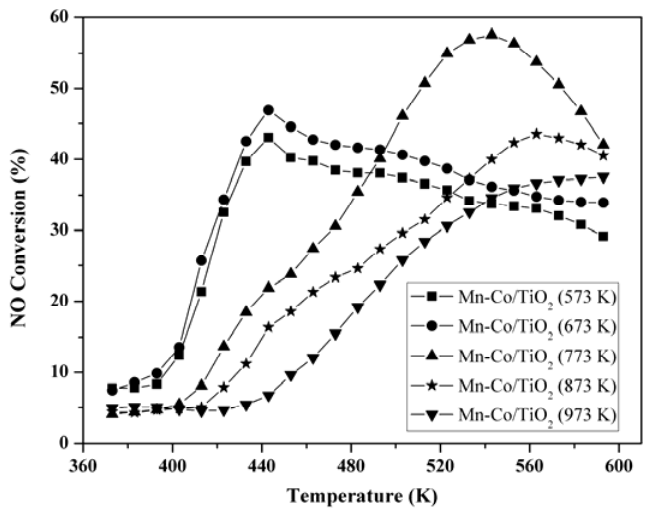
Figure 2. NO oxidation efficiency of 10Mn-5Co/TiO 2 catalysts calcined at different temperatures. Reaction conditions: [NO] = 400 ppm, [O 2 ] = 5%, Ar balance, GHSV = 42,000 h − 1 .